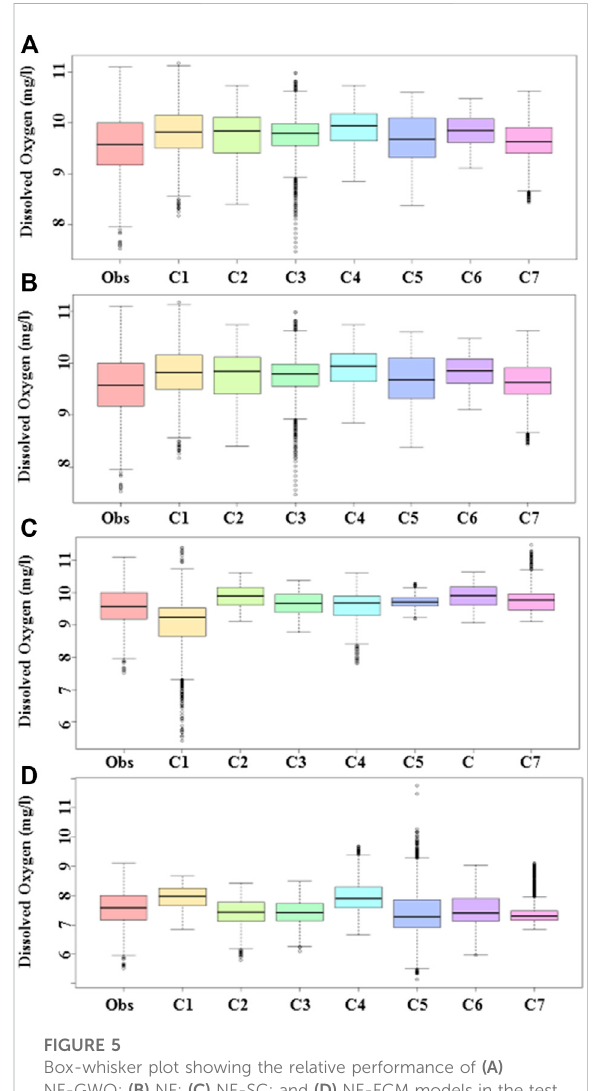
FIGURE 5 Box-whisker plot showing the relative performance of (A) NF-GWO; (B) NF; (C) NF-SC; and (D) NF-FCM models in the test phase at Station-A.